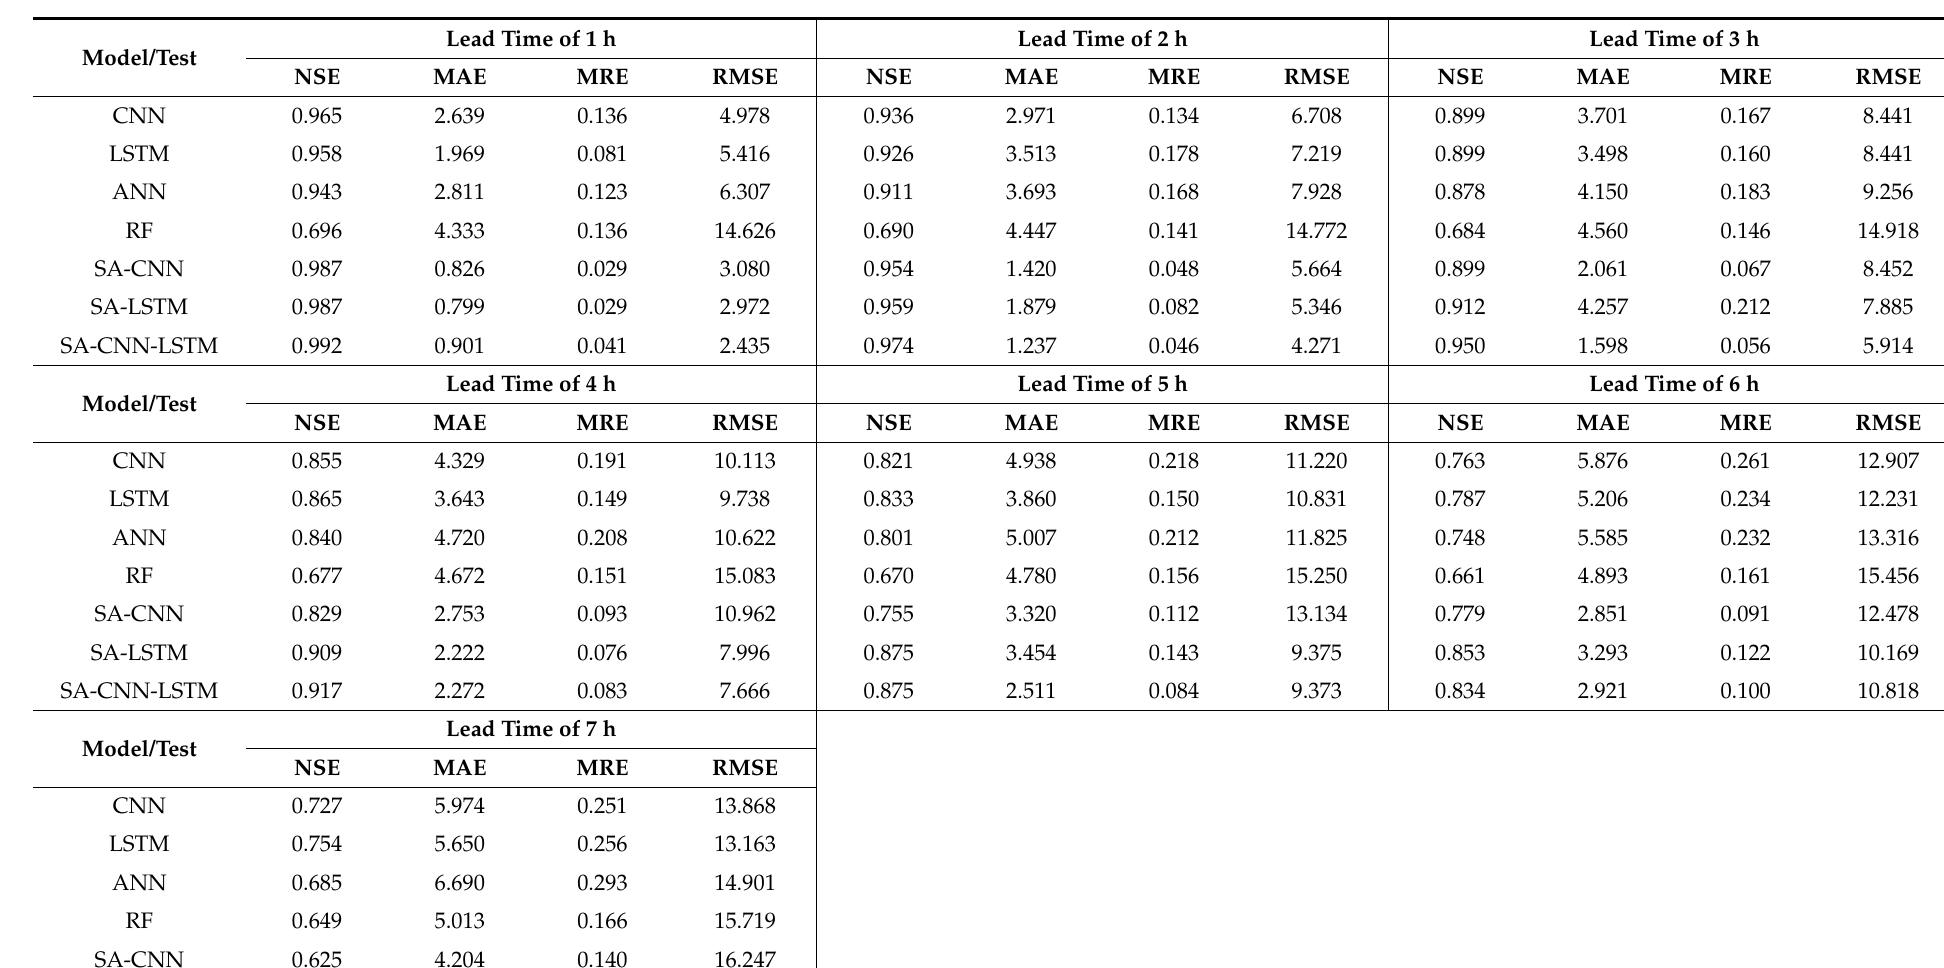
Table 3. Performances of each model in the testing